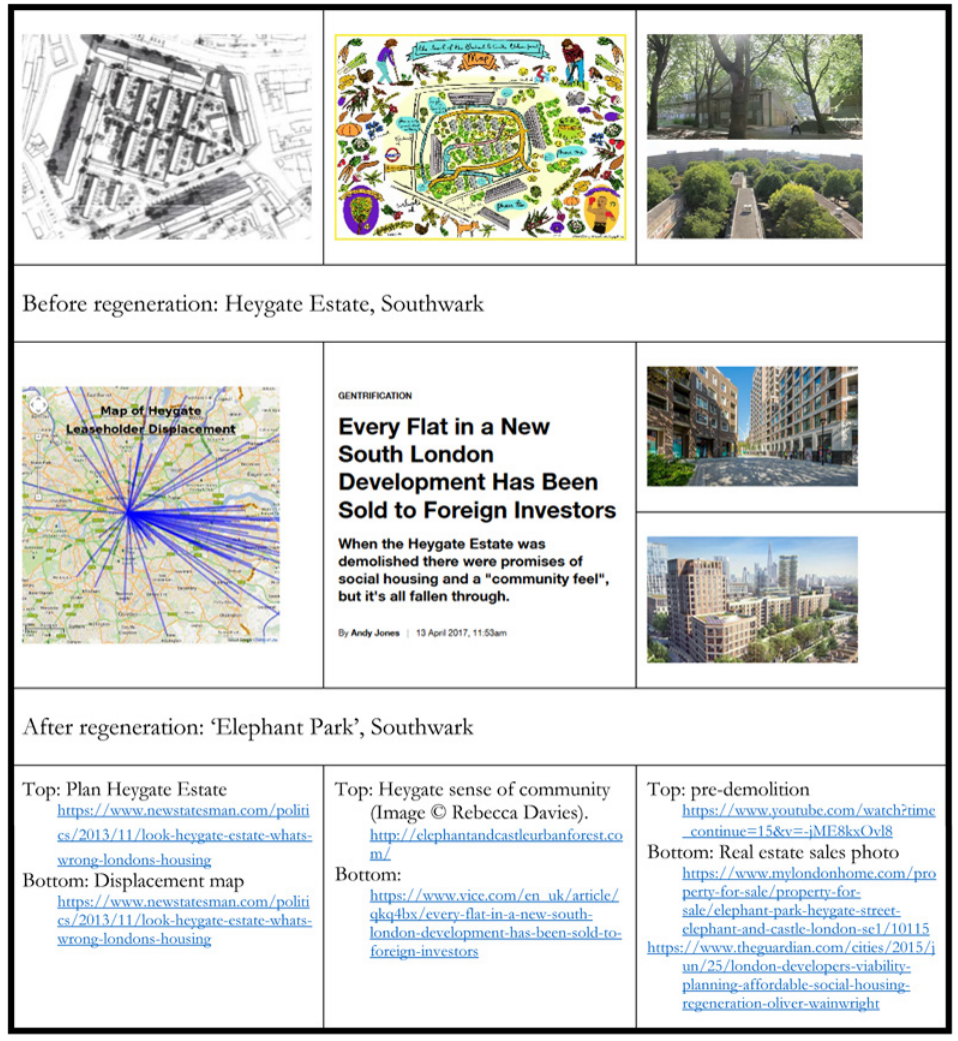
Figure 2 Heygate Estate becomes Elephant Park: controversial and fiercely contested urban